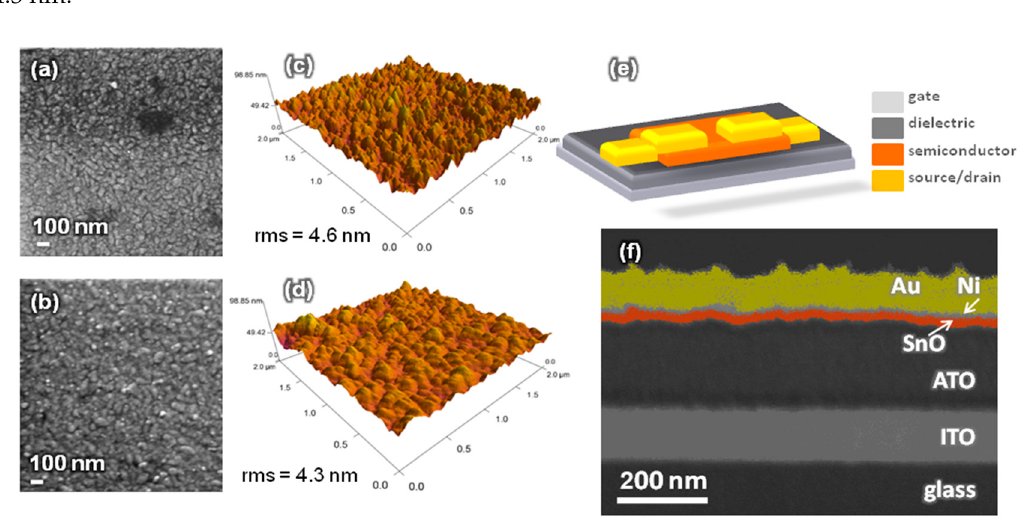
Figure 4. After annealing (60 mn) scanning electron microscope (SEM) images of SnO x